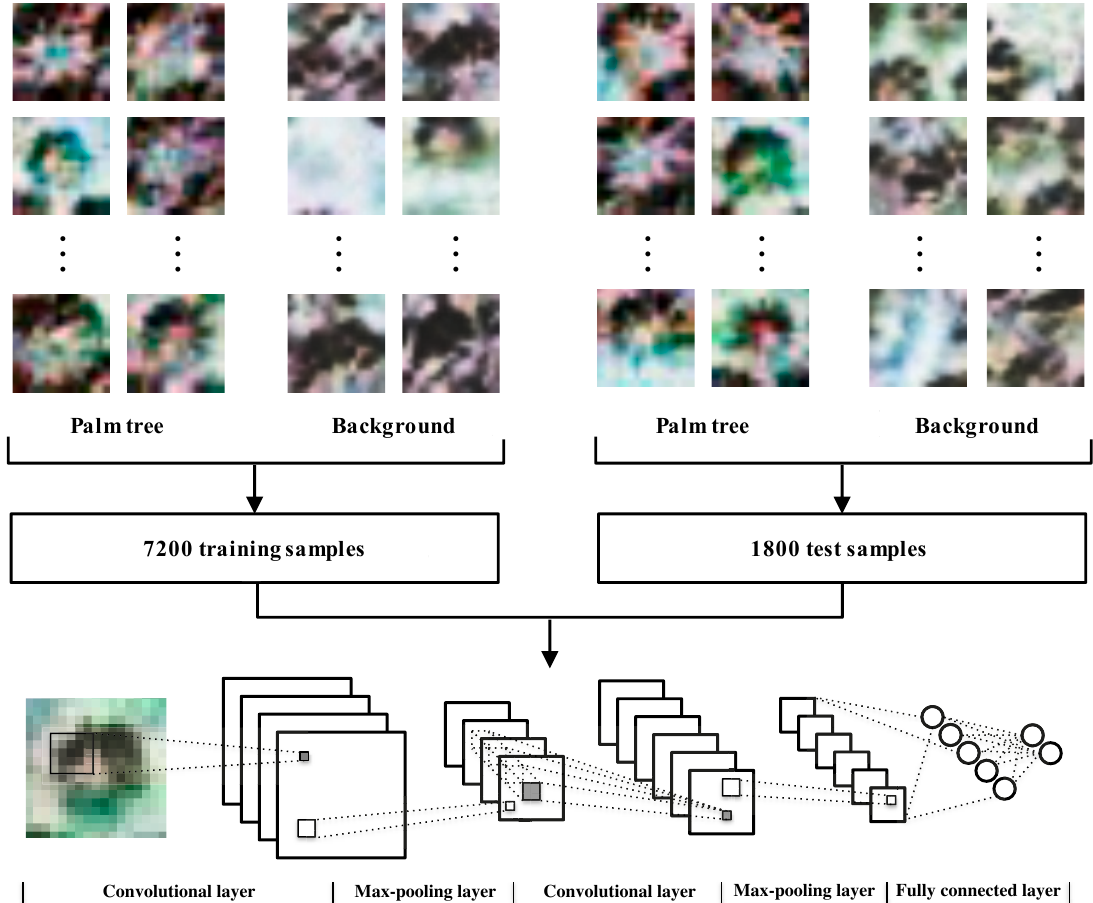
Figure 3. The structure of the convolutional neural network